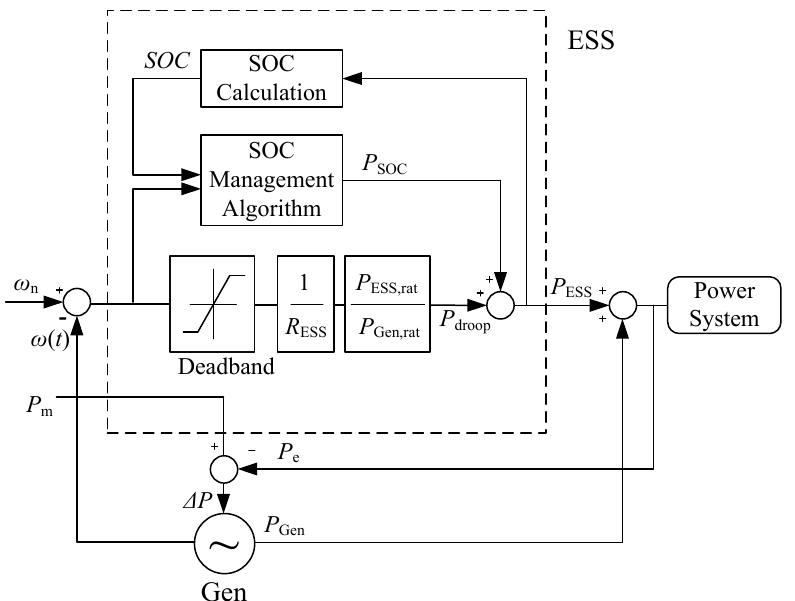
Figure 3. Proposed ESS operation method for FR and SOC management interfacing with synchronous